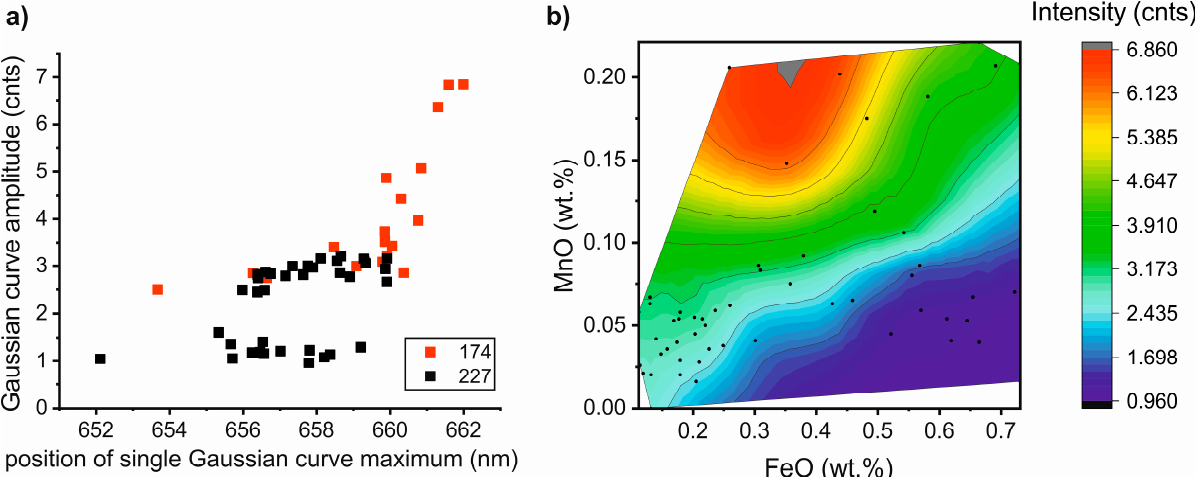
Figure 11. Correlation of parameters derived from the single Gaussian curve fit of CL-spectra of dolomite and the Mg- and Fe-admixture: ( a ) position of the centre of the single Gaussian curve vs. the amplitude of the curve (i.e., the maximum intensity); ( b ) correlation among CL intensity and dolomite chemistry. Sample No. 174—Raspenava, sample No. 227—Bohdane č .